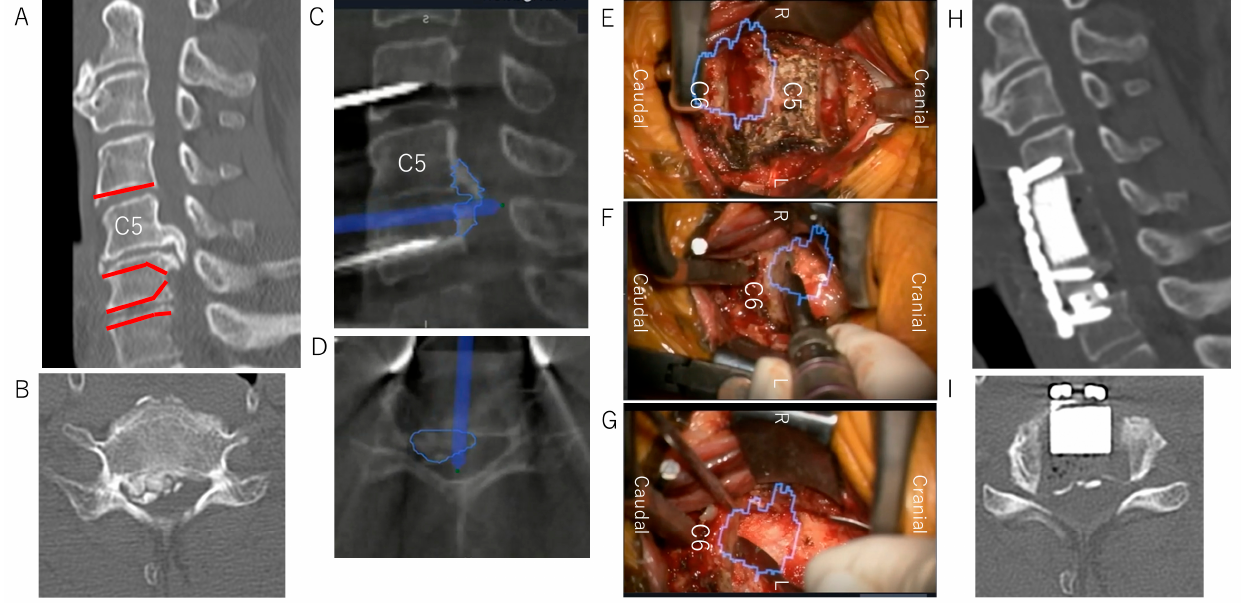
Figure 4. Case presentation. ( A , B ) Preoperative sagittal and axial CT views and the plan of the decompression line of the OPLL by undercutting cranially or caudally at the posterior aspect of the preserved vertebrae (red line). ( C , D ) Intraoperative sagittal and axial CT views of the OPLL, which were reconstructed after marking the outlines of ossification (blue line). ( E – G ) Intraoperative micro- scopic views with AR support and outlines of ossification (blue line): ( E ) before OPLL decompression, ( F ) during OPLL decompression, and ( G ) after OPLL floating. ( H , I ) Postoperative sagittal and axial CT views of sufficient OPLL floating. CT, computed tomography; OPLL, ossification of the posterior longitudinal ligament.